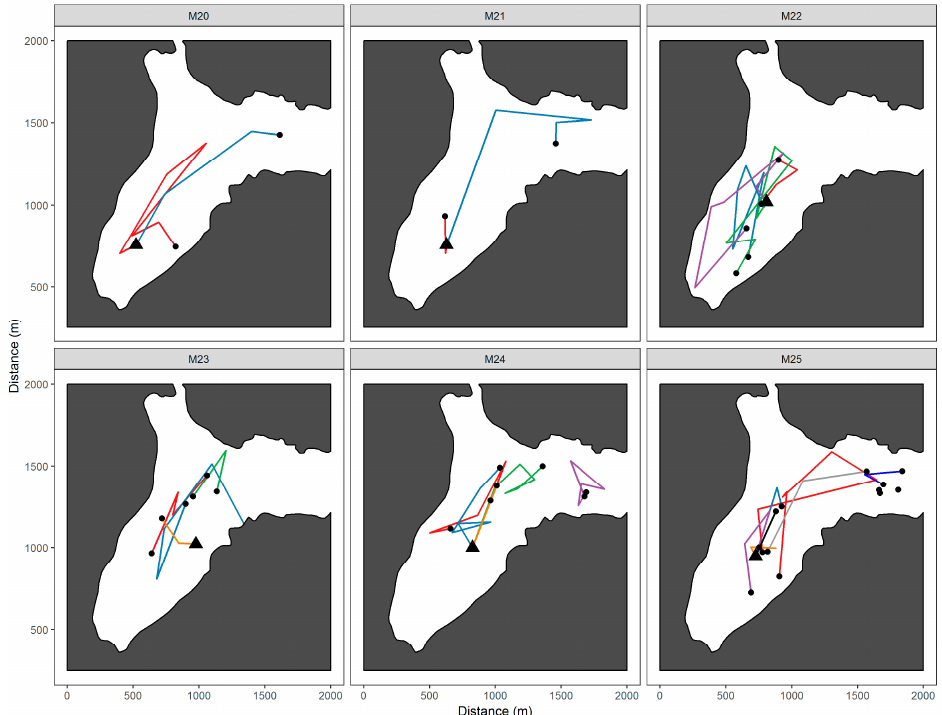
using an autonomous underwater vehicle during a series of survey missions in Big Port Walter, Alaska. The site where the fish were initially released (black triangle) and the last location of the fish (black dot) are indicated.